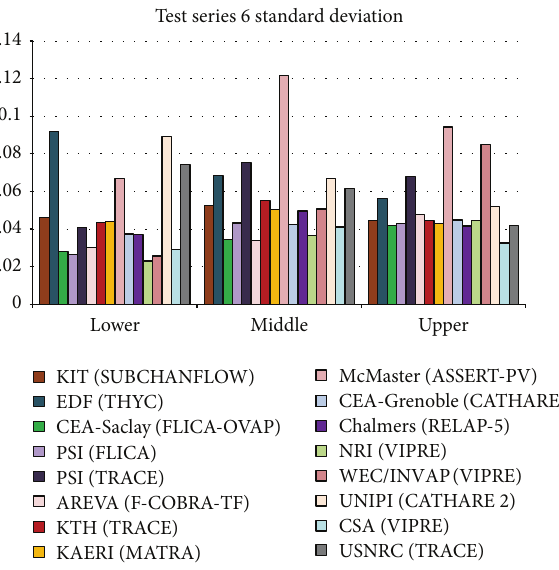
Figure 24: Test series 5 void fraction standard deviation.